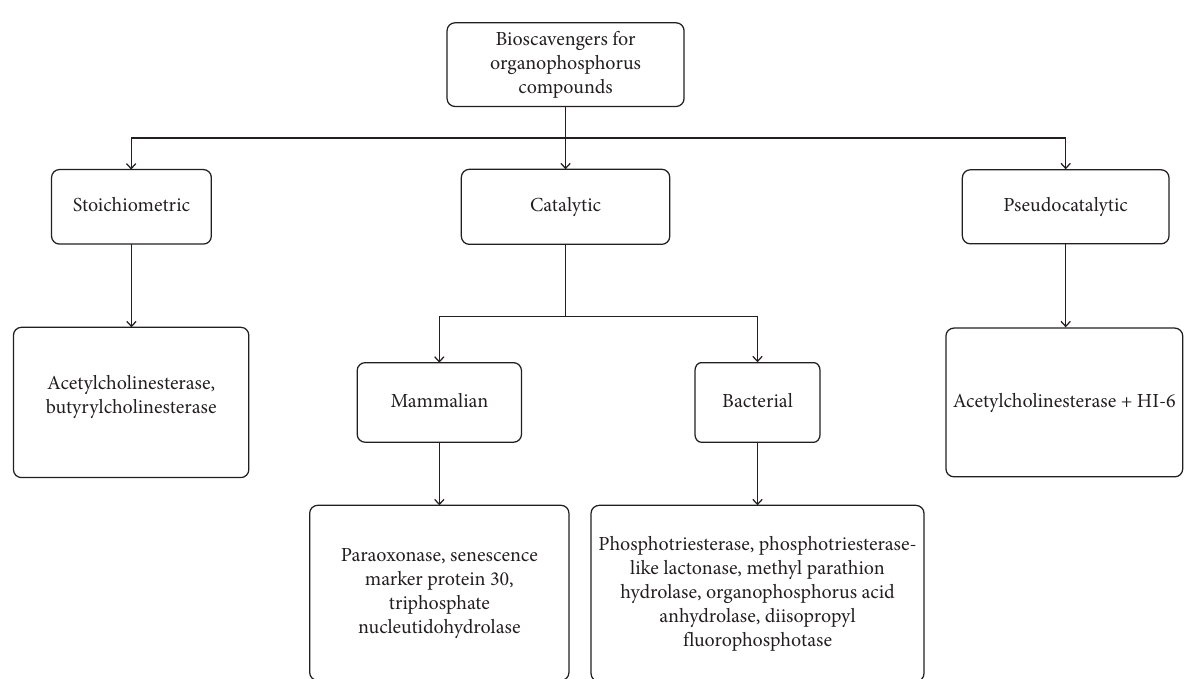
Figure 3: Classification of bioscavengers for organophosphorus compounds. The flowchart represents the classification of OPC hydrolysing enzymes on the basis of their hydrolysing ability into three categories, namely, stoichiometric, catalytic, and pseudocatalytic with their examples. The catalytic bioscavengers are further divided into two groups, bacterial and mammalian.